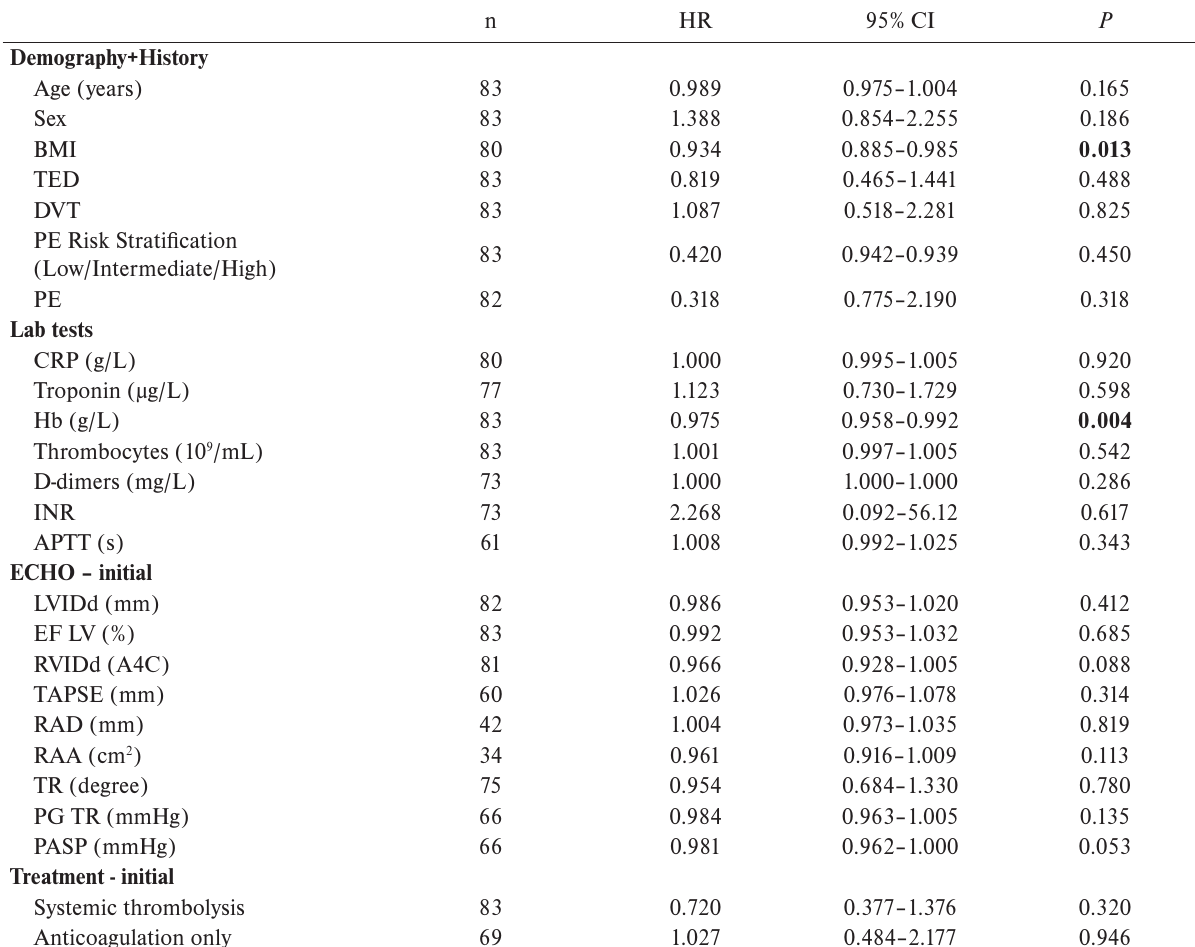
Table 2. Cox proportional hazards model of reperfusion – one-dimensional models based on the parameters acquired during the initial examination. n HR 95% CI